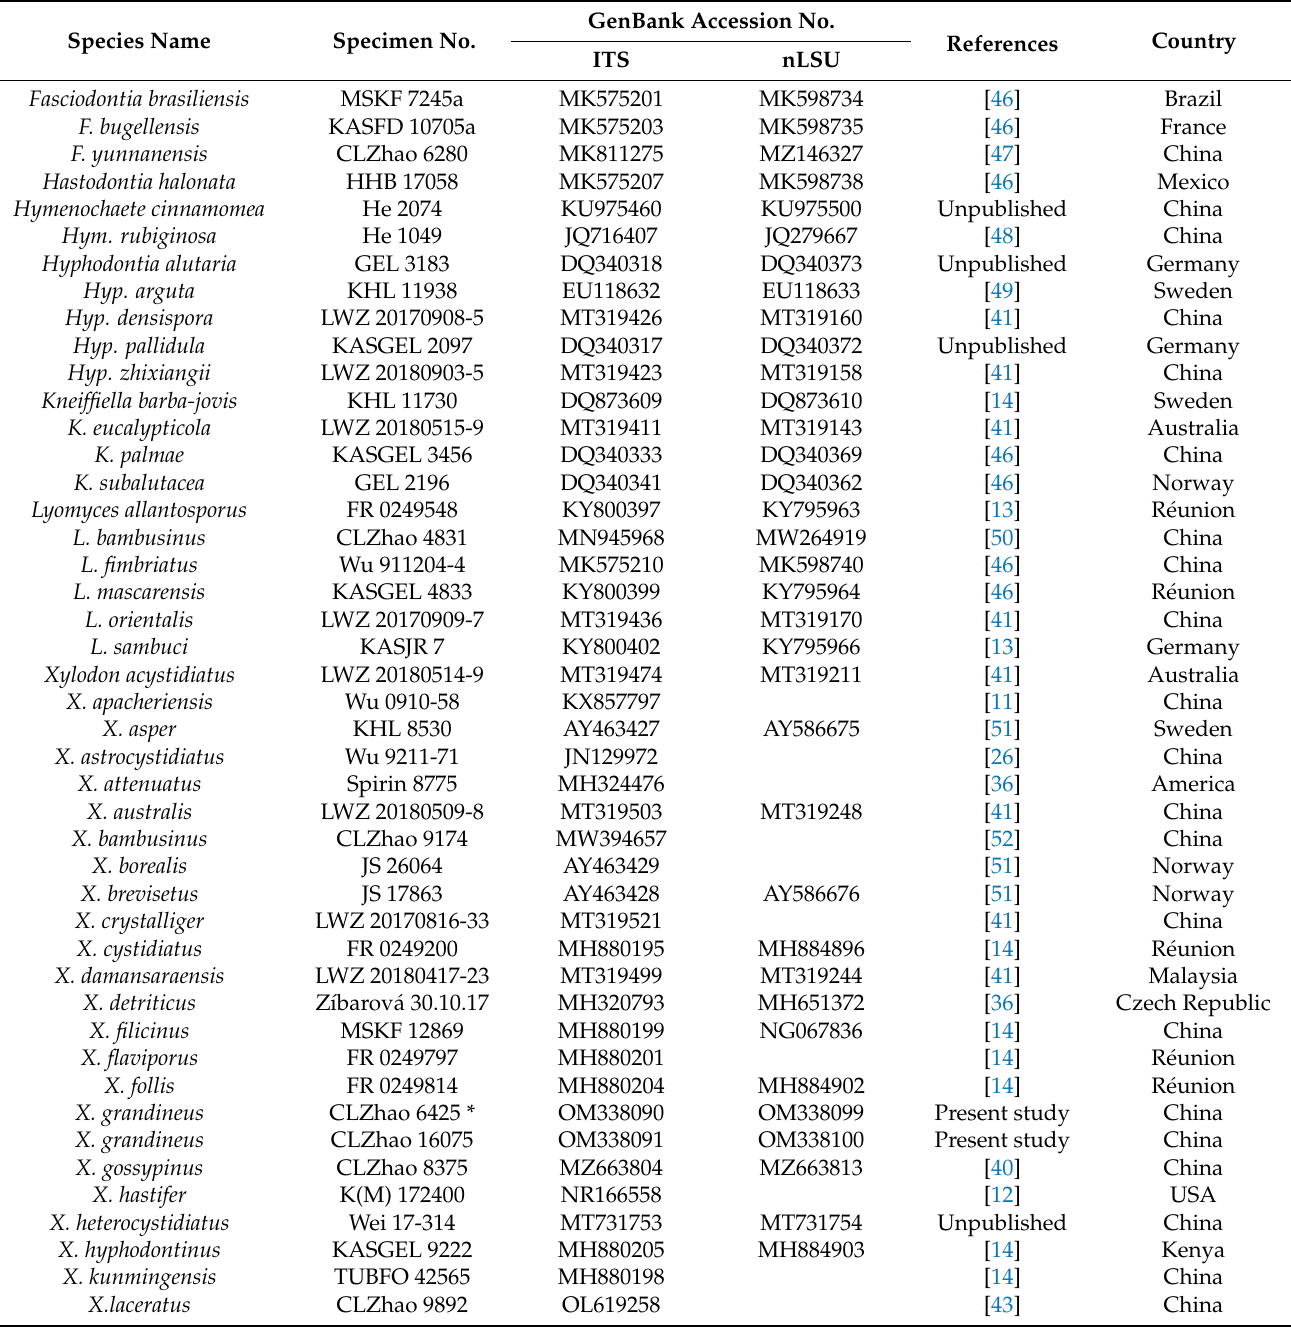
Table 1. List of species, specimens, and GenBank accession numbers of sequences used in this